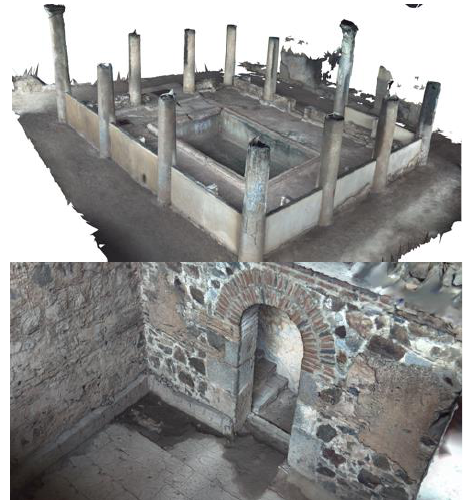
Figure 4. 3D mesh textured of the Pond and Peristylum (area 1)(up) and of the underground room(area 2)